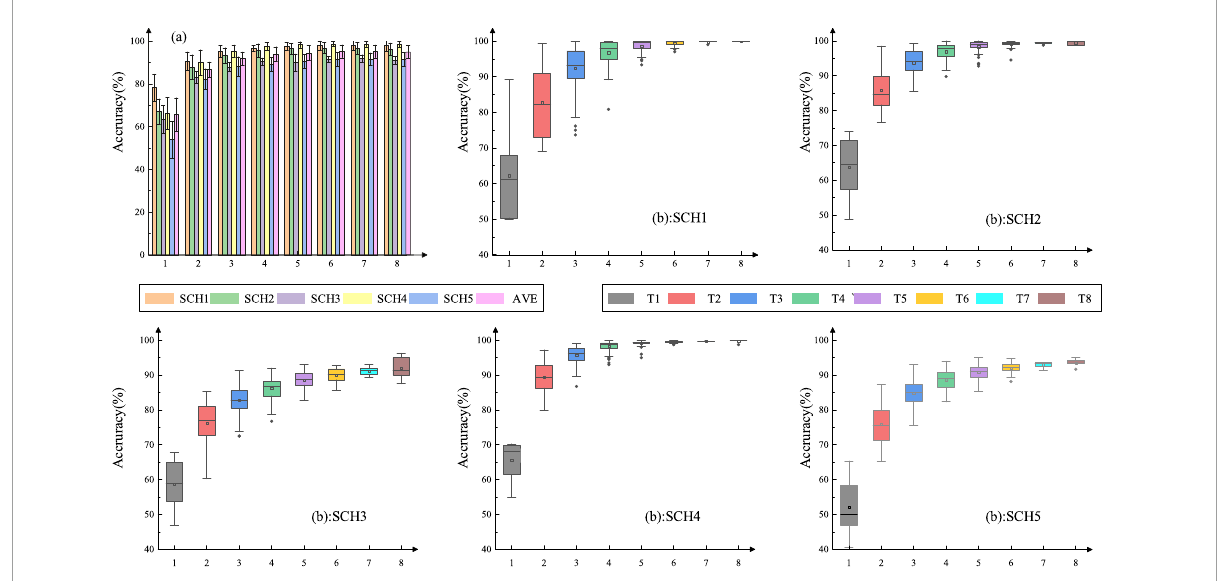
FIGURE5 Average recognition rate about the five classification schemes under different total numbers of channels and the box diagram of subject one. The horizontal axis represents the total number of channels. SCH1: four-class classification for four actions without using force information. SCH2: eight-class classification for four actions with level 1 and level 2 of force. SCH3: eight-class classification for four actions with level 2 and level 3 of force. SCH4: eight-class classification for four actions with level1 and level3 of force. SCH5: 12-class classification for four actions with level1, level2, and level3 of force. The horizontal axis represents the total number of